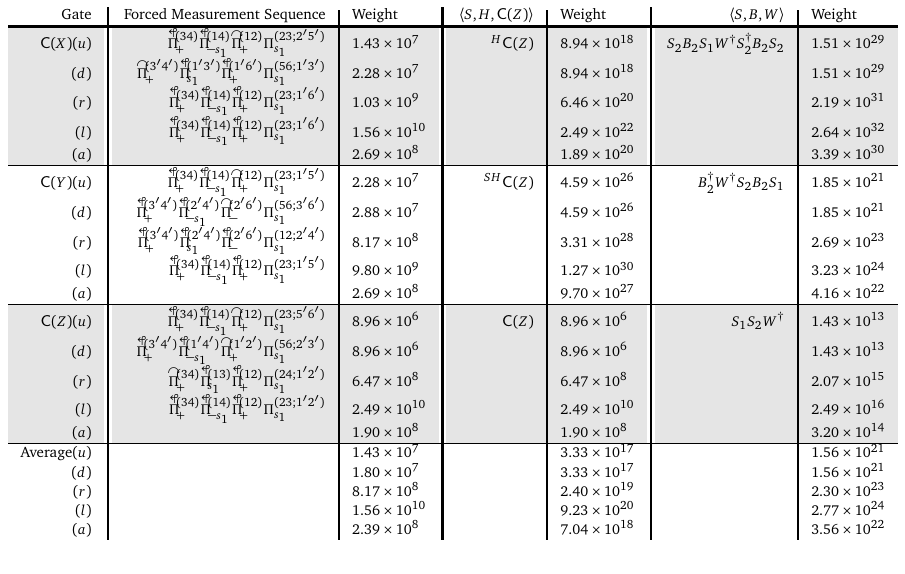
Table 24: Minimal difficulty weight measurement sequences for controlled-Pauli two-qubit gates when using forced-measurement methods. The labels ( u ) , ( d ) , ( r ) , and ( l ) indicates that for a hexon acting as the control qubit of the C ( P ) gate, the corresponding target qubit is the nearest neighbor hexon in the up, down, right, and left direction, respectively. Notice that the choice of control and target qubit is arbitrary for C ( Z ) , so ( u ) and ( d ) are related by symmetry, as are ( r ) , and ( l ) . The average difficulty weight of the four directions is labeled by ( a ) . For comparison, we also present the corresponding realization of the gates formed by using the generating gate sets 〈 S , H , C ( Z ) 〉 and 〈 S , B , W 〉 . A C ( Z ) = A denotes conjugation of C ( Z ) by A on the target